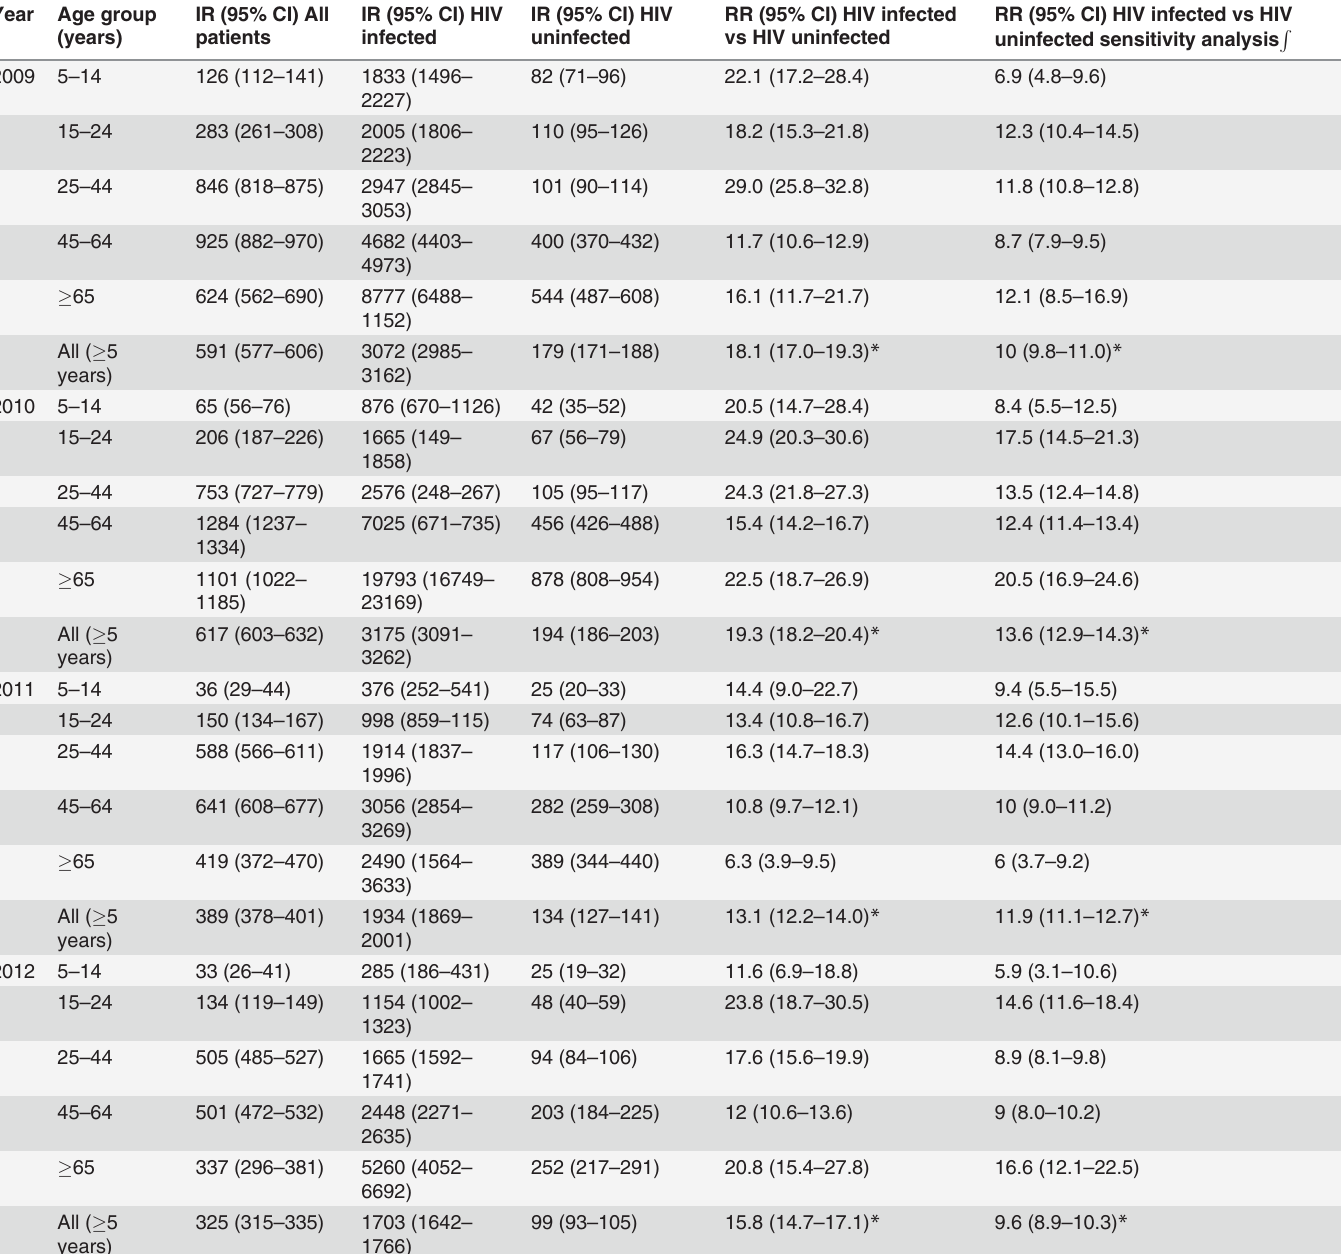
Table 3. Incidence of severe acute respiratory illness (SARI) hospitalisations per 100,000 population by year and HIV status at Chris Hani- Baragwanath Hospital, South